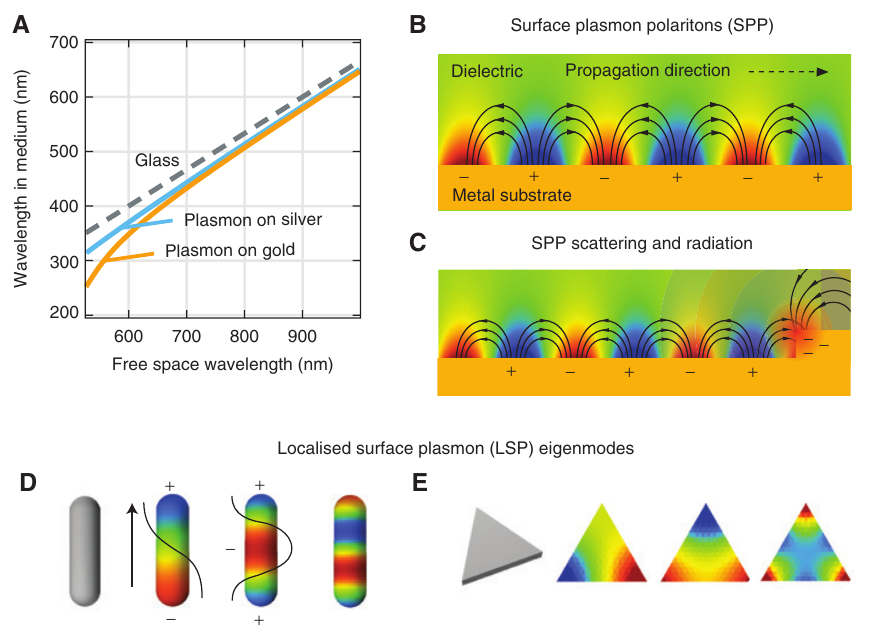
Figure 2: Plasmons propagating on surfaces: (A) The wavelength of an SPP is shorter than the free space wavelength of light or the wavelength within the dielectric, which prevents the plasmon from radiating; (B) the electric field associated with an SPP propagating over the surface of a thick metal film; (C) illustration of a plasmon scattering at a discontinuity with some energy converted to radiation in the dielectric; (D–E) examples of LSPs on different metal particles. These show the charge distributions (blue positive, red negative) of different resonant modes. The fundamental mode is a half wavelength with a strong dipole